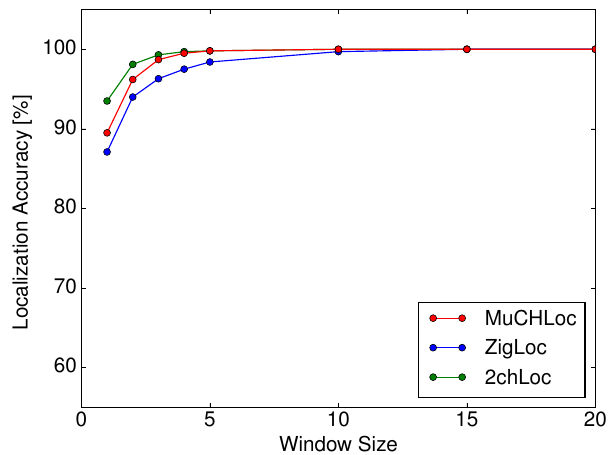
Figure 11. Localization accuracy in a static environment as a function of window size w .